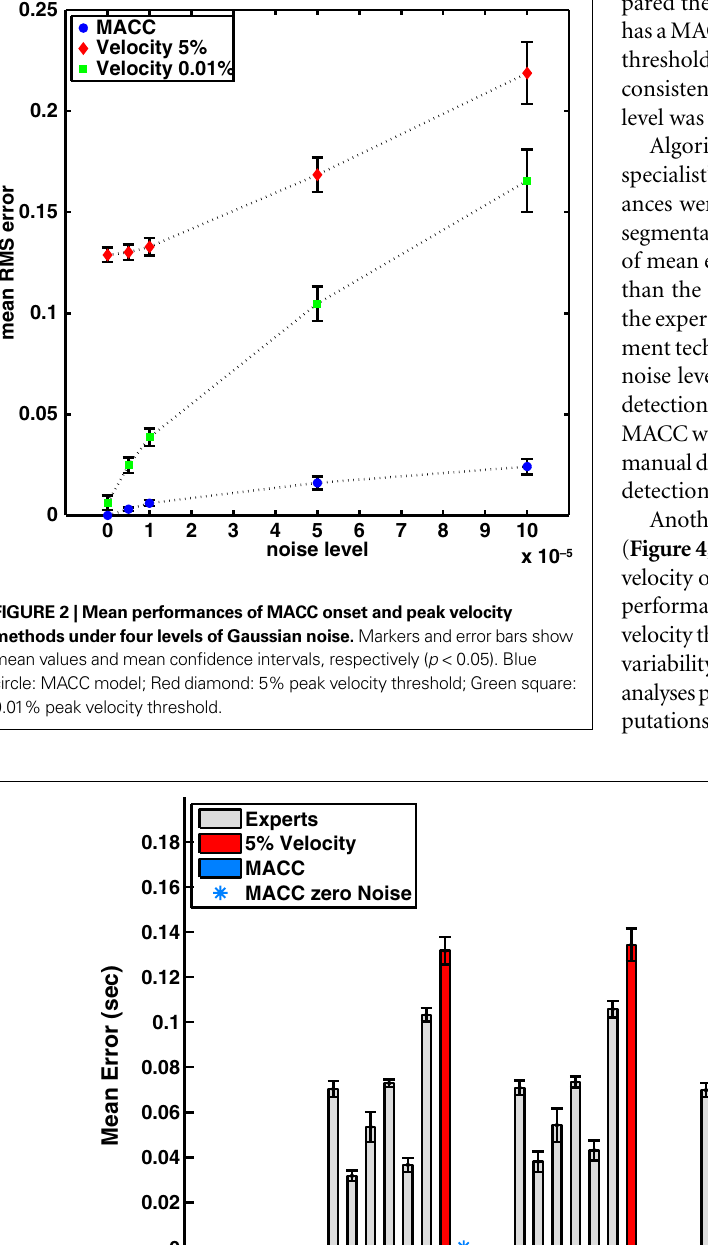
shows mean confi dence intervals ( p < 0.05). Gray: performances of six manual experts; Blue: automatic MACC model performance; Blue star: MACC model accurate performance without noise; Red: automatic 5% peak velocity threshold.